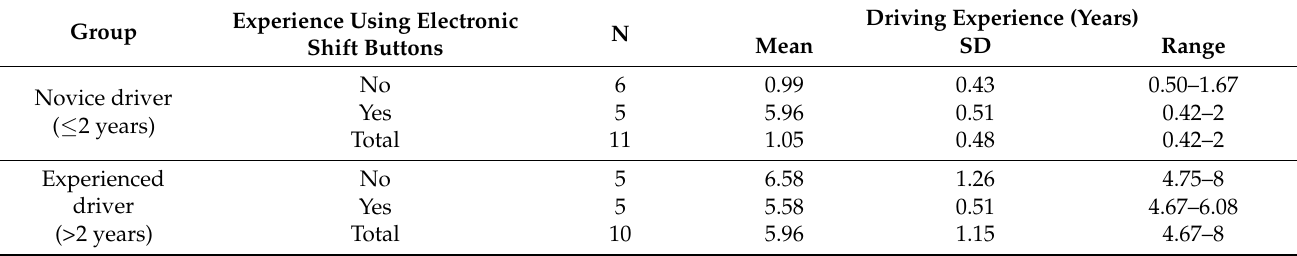
Table 2. Respondent